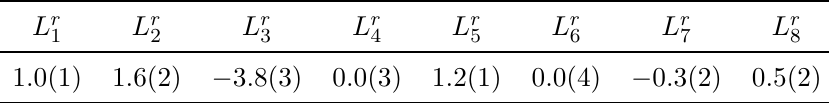
Table 3 . Values for the LECs (in units of 10 − 3 ) taken from ref. [64]. We choose the results of the combined fit at NLO for the range − 0 . 3 × 10 3 ≤ L r µ = 0 . 77